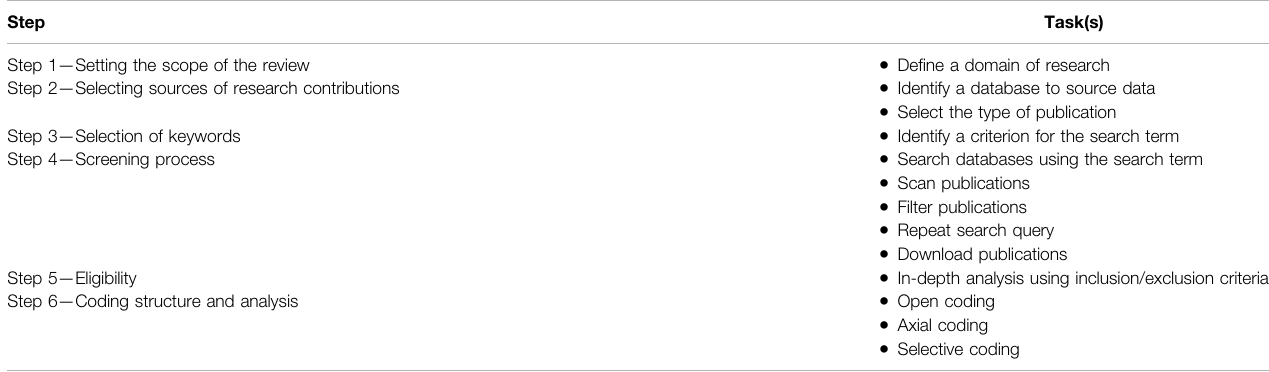
TABLE 1 | Grounded theory methodology style of analysis for literature